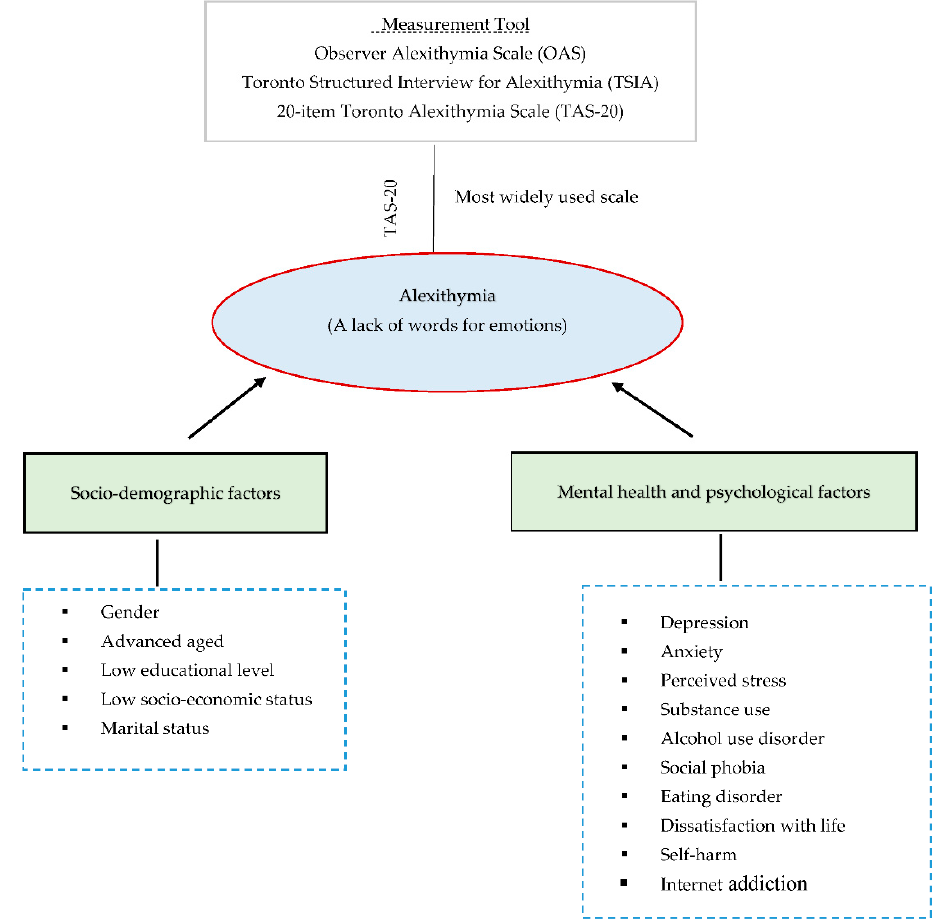
Figure 1. Framework indicating the social and other (such as psychological factors) determinants of alexithymia. (Note: The framework is prepared by the authors based on the literature.)